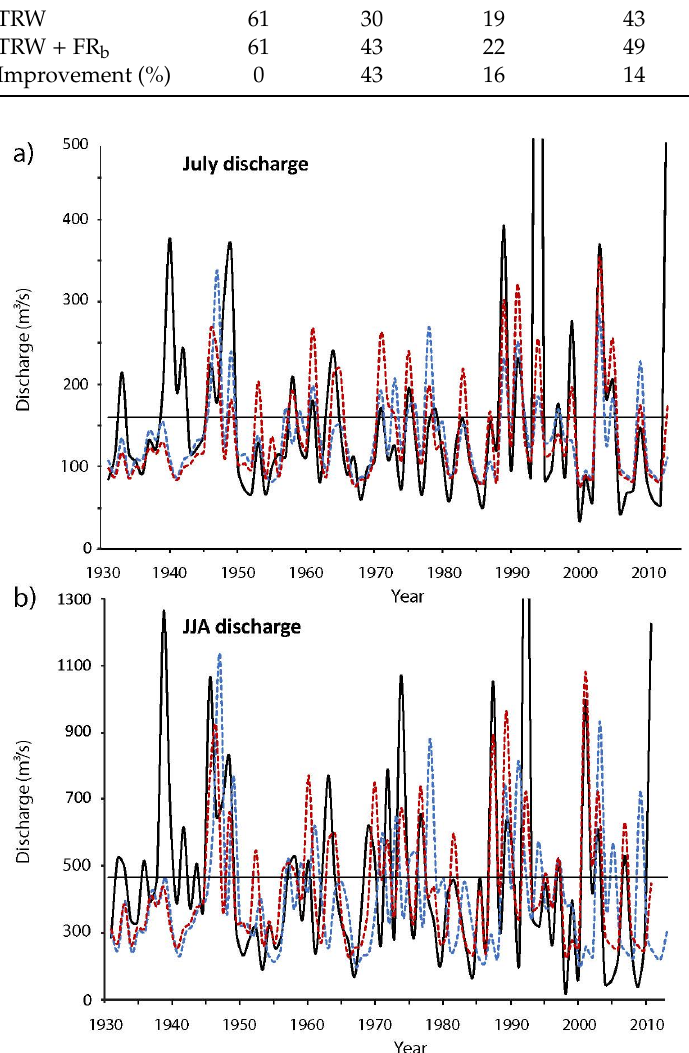
Figure 8. Time series of observed ( thick black line ), total ring width-modeled ( blue dashed line ), total ring width + FR b -modeled ( red dashed line ) and observed mean discharge ( thin black line ) for